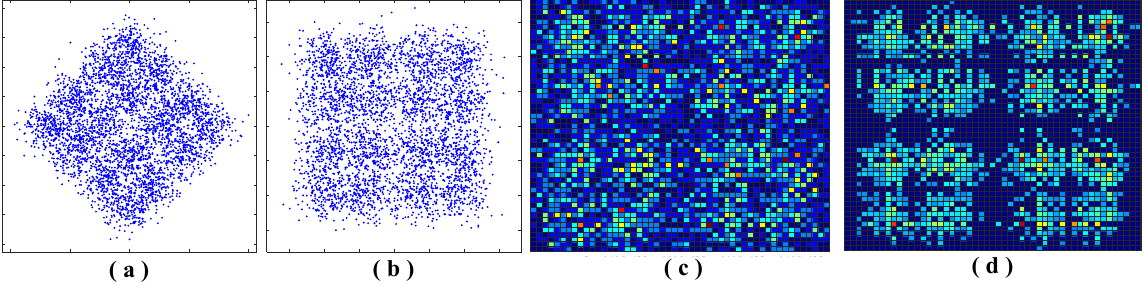
Figure 7. The process and effect of the proposed MFI method after the square operation, take the 16QAM signals for example. ( a ) Constellation before principal axes correcting; ( b ) Constellation after principal axes correcting; ( c ) Density matrix obtained by DDA; ( d ) Density distribution matrix after denoising and smoothing based on SVD.